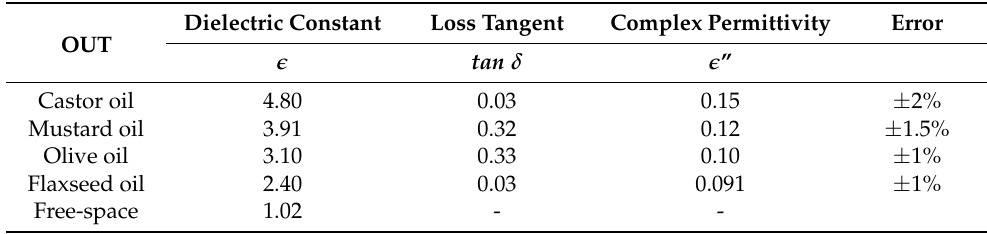
Table 2. Permittivity and loss tangent